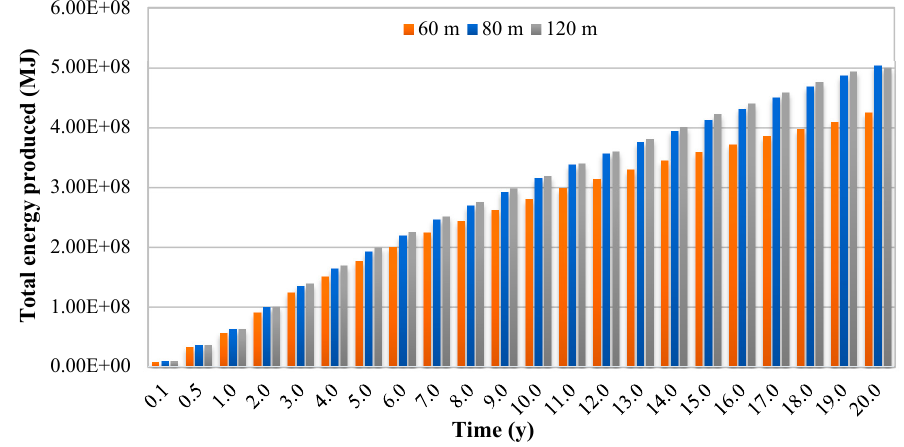
Figure 10 . Comparative results of produced net heat and heat production power within 20 years with 60, 80, and 120 m fracture spacing.